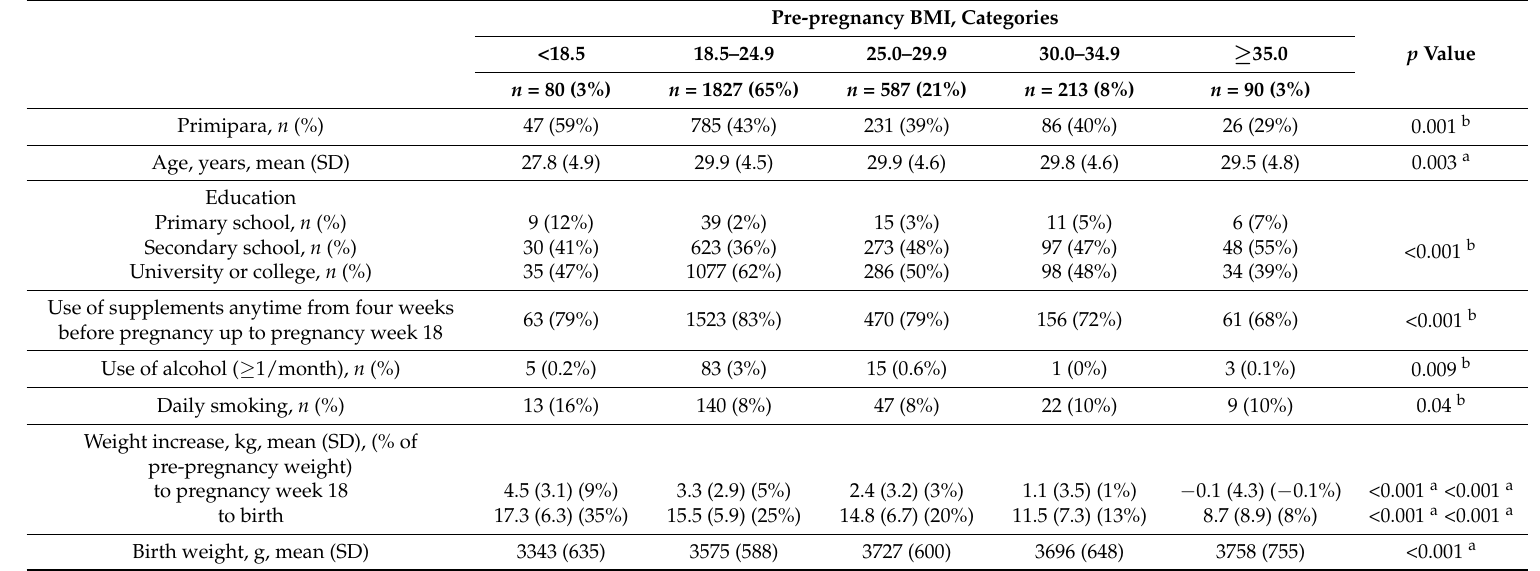
Table 1. Maternal characteristics according to maternal pre-pregnancy BMI, n =